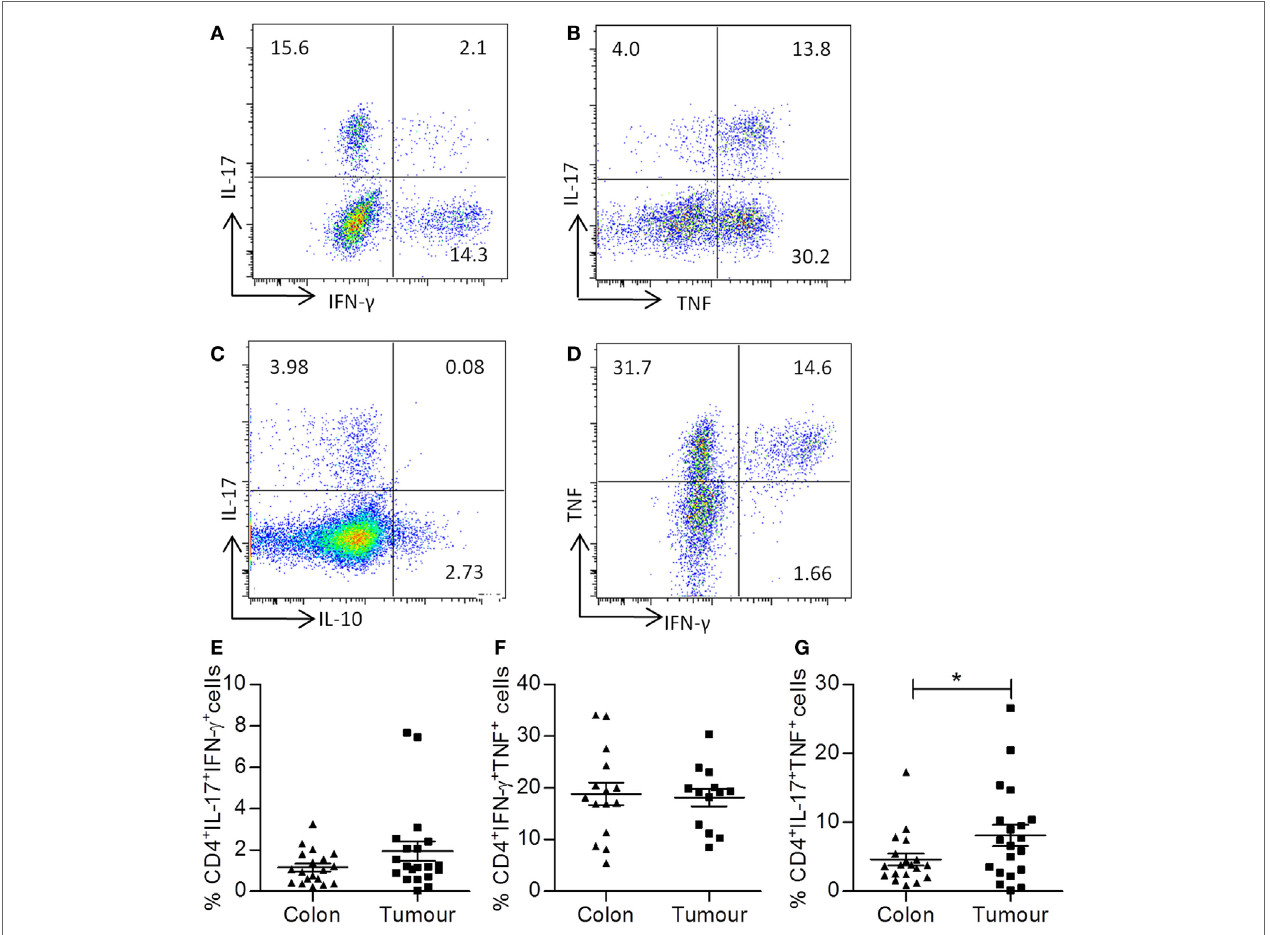
FigUre 3 | Th17 cells infiltrating colorectal tumors coexpress TnF- α , but not iFn- γ . Single cell suspensions that were obtained from tumor tissue and adjacent uninvolved colonic tissue were stimulated with PMA and ionomycin. Cells were stained with antibodies specific for CD3 and CD8, permeabilized, and stained for intracellular expression of the cytokines TNF- α , IFN- γ , and IL-17. Representative dot plots were gated on CD4 + (CD3 + CD8 − ) T cells and show expression of IL-17 versus IFN- γ (a) , IL-17 versus TNF- α (B) , IL-17 versus IL-10 (c) , or TNF versus IFN- γ (D) . The frequencies of CD4 + IL-17 + IFN- γ + (e) , CD4 + TNF + IFN- γ (F) , or CD4 + IL-17 + TNF- α + (g) T cells are shown for uninvolved colon and colorectal tumor tissue. * p < 0.05 as determined by the Wilcoxon signed rank